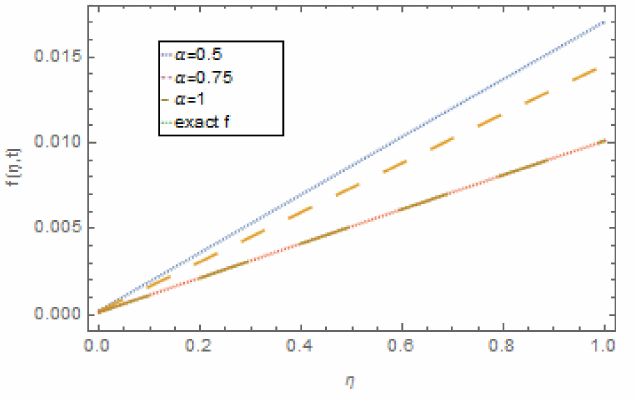
Figure 7. 2D plot of approximate solution for α